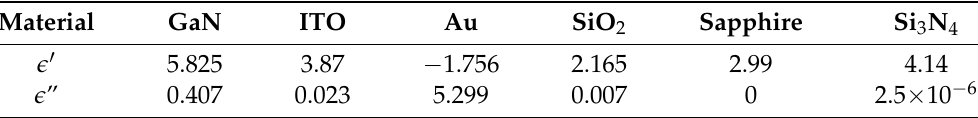
Table 1. The values of real and imaginary parts of dielectric functions used in modeling and adopted after [24–27]. Notice that the values are taken for λ = 450